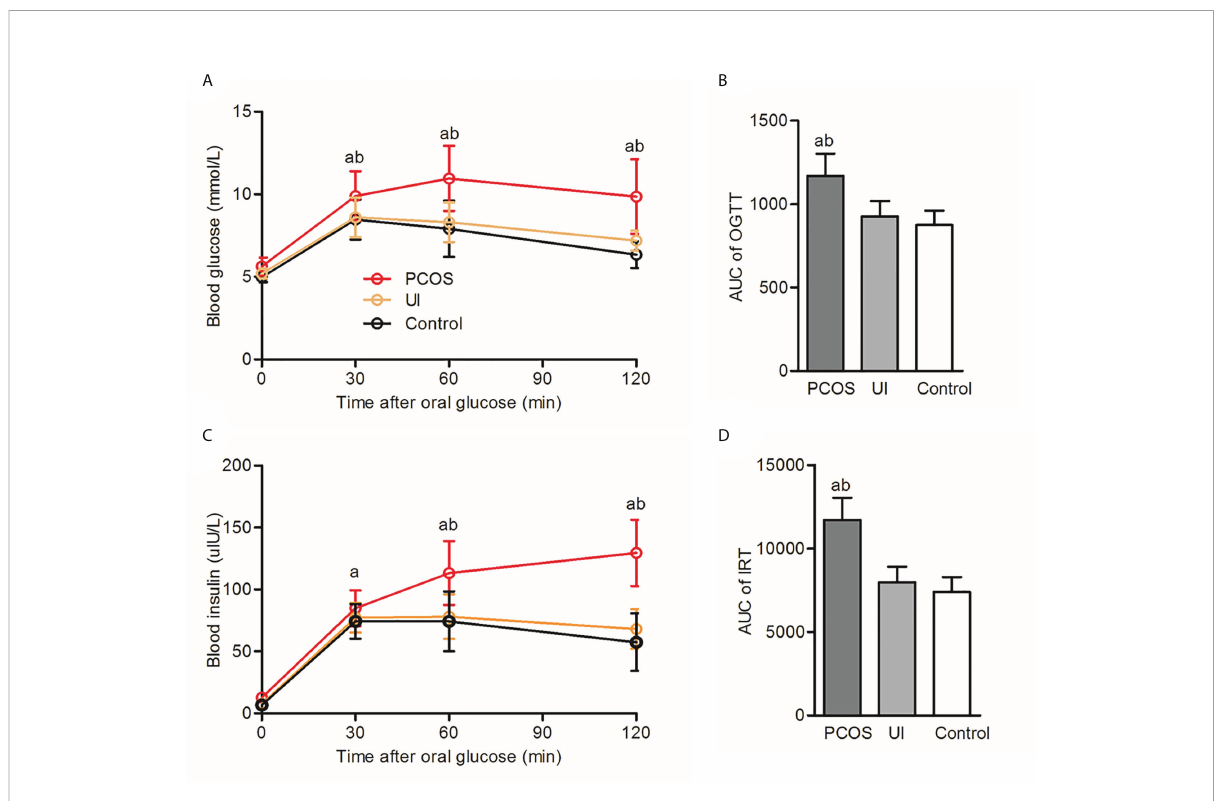
FIGURE 1 Oral glucose tolerance test (OGTT) and insulin release test (IRT) in infertile patients with and without PCOS and in the control group. (A, B) : Comparison of the oral glucose tolerance test (OGTT) and corresponding area under the curve (AUC) among PCOS, UI and the control group. (C, D) : Comparison of insulin release test (IRT) and corresponding area under the curve (AUC) among PCOS, UI and the control group. Two-way ANONA followed by two group comparison. a P < 0.05 compared with control group, b P < 0.05 compared with UI group.